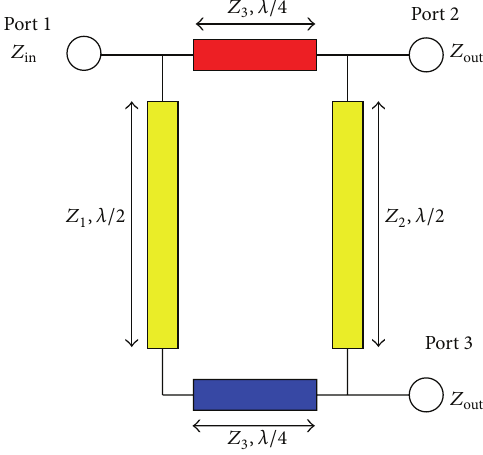
Figure 3: Topology of the optimized two-section half-wave